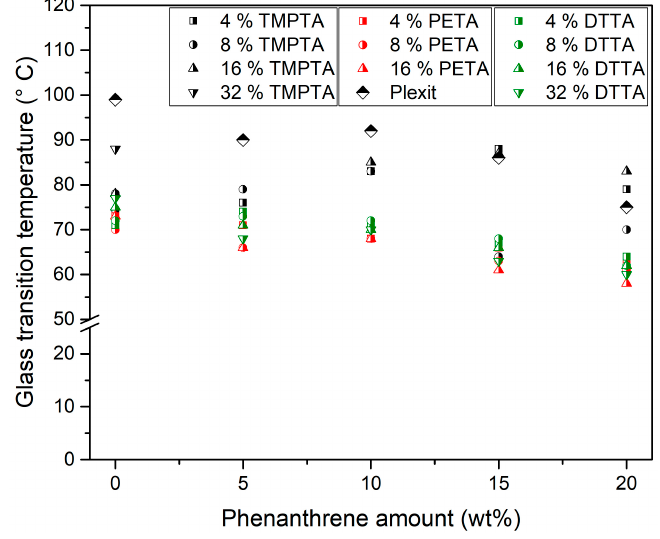
Figure 8. Glass transition temperatures of all investigated systems after curing.